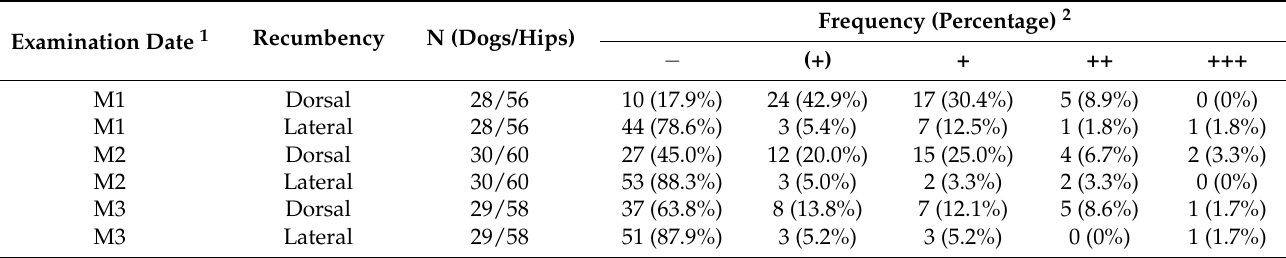
Table 1. Descriptive statistics of the Ortolani tests reported for each examination